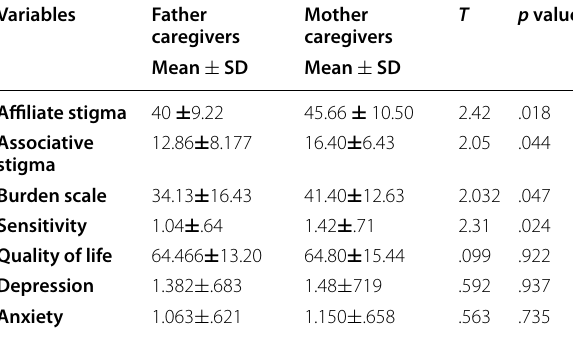
Table 3 Comparison of affiliate stigma and associative stigma, burden scale, and sensitivity, between father caregivers and mother caregivers of both